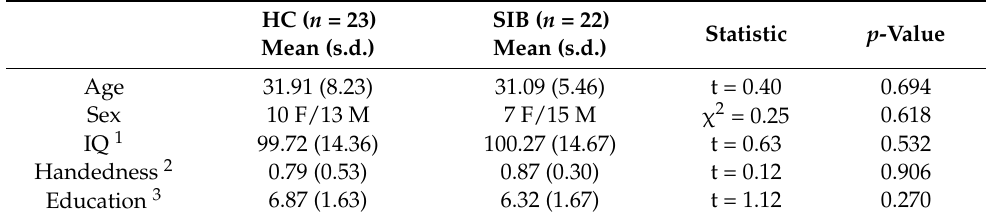
Table 2. Demographic